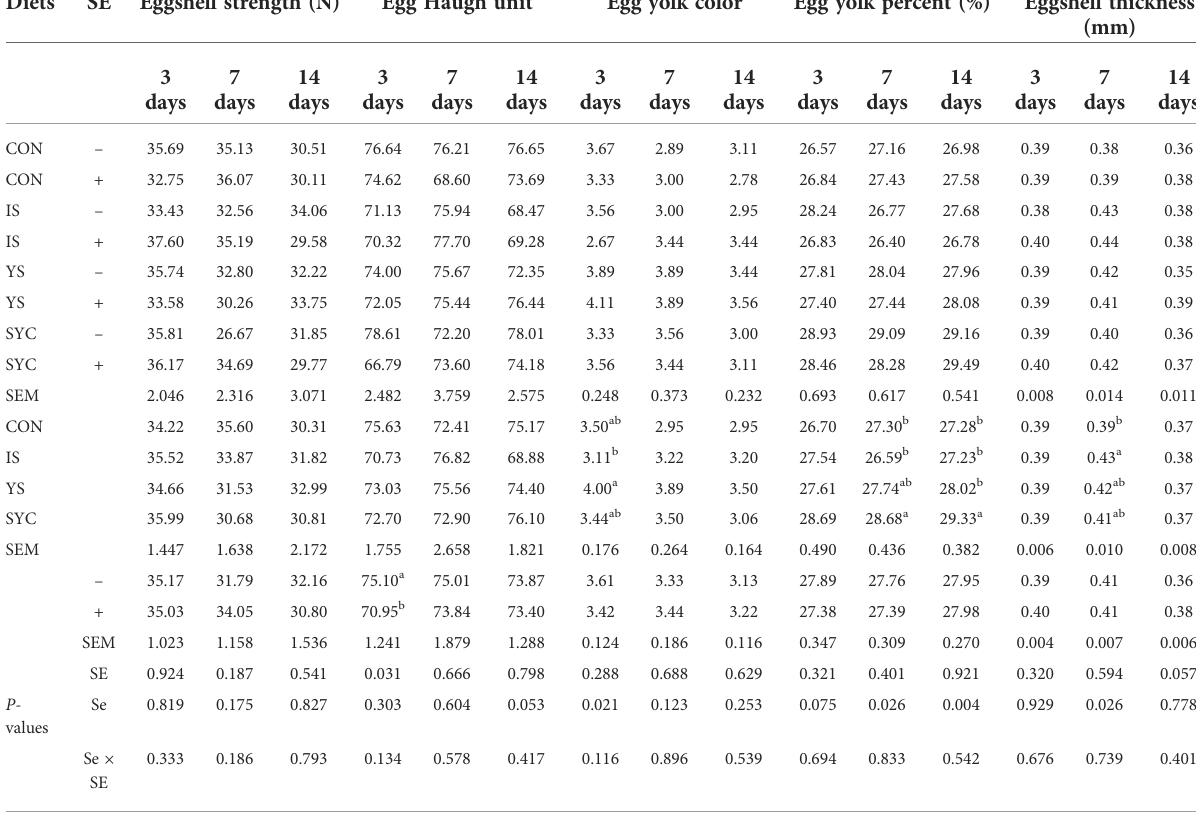
TABLE 3 Effects of different selenium sources in diets on the quality of eggs challenged by S. Enteritidis . Diets SE Eggshell strength